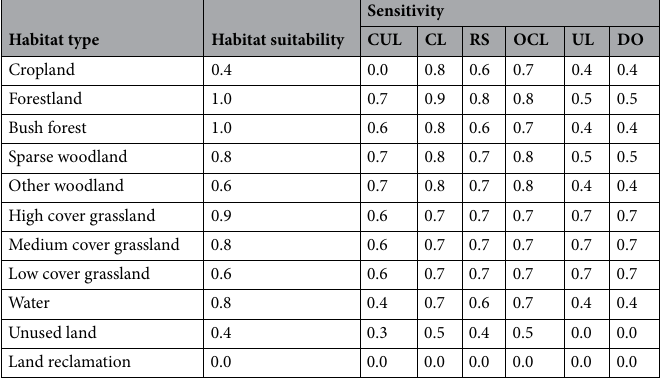
Table 2 . Sensitivity of habitat types to each threat factor. CUL, cultivated land; CL, construction land; RS, rural settlement; OCL, other construction land; UL, unused land; DO, decreased